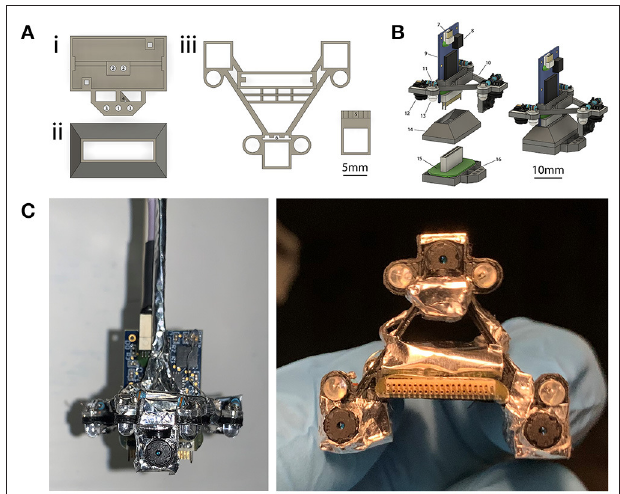
FIGURE 2 | Four-camera headset design. (A) 3D-printed components used for implants and headsets. (i) Implant base that is implanted on the head. A Neuralynx EIB is attached to the implant base. (ii) Protective cap that snaps onto the implant to allow for social housing when the camera assembly is not in use. (iii) Camera carrier that holds the cameras and their associated LEDs. The ear-facing cameras are each paired with a single LED for illumination, whereas the overhead camera has two LEDs (for illuminating the left and right side of the mouse’s face), and the forward-facing camera does not have an LED. The forward facing camera holder is attached to the main camera carrier component after printing. Numbered labels indicate (1) tetrode drive screw, (2) tetrode guide rails, (3) optional independent camera mount, (4) tetrode guide cannulae, (5) forward camera holder (6) receiving slot for forward camera holder. For further details on labels 1–4 see section Methods: Implants, for labels 5–6 see section Methods: Four-Camera Headset, Construction. (B) Rendered view of the components in (A) , separately at left and assembled at right. Numbered labels indicate (7) SPI cable connector, (8) integrated accelerometer, (9) Intan 32-channel headstage, (10) camera carrier, (11) resistor, (12) camera module, (13) IR LED, (14) protective social cap, (15) Neuralynx EIB, and (16) implant base. (C) A view of the headset assembled around the headstage from the front (left) and underneath